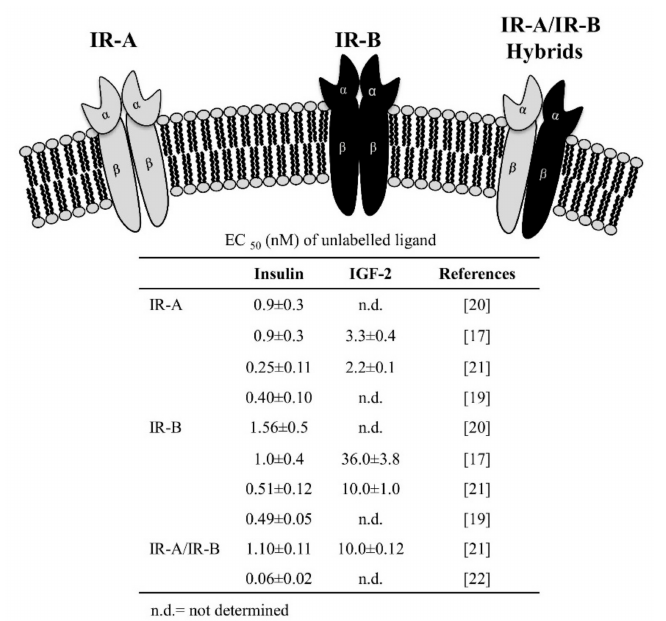
Figure 1. Schematic representation of the insulin receptor (IR) isoforms. Homodimerization of the αβ subunits A or B produces IR-A and IR-B. Heterodimerization of one A and one B αβ subunit forms the hybrid IR. The isoforms are generated by alternative splicing of exon 11 that encoded a 12-amino acid segment in the C-terminus of the α subunit, present in IR-B, but not in IR-A and this difference cause the difference in structure/function. The table indicates the affinity binding (expressed as EC 50 of unlabeled ligand) to insulin and IGF-2 for the IR isoforms and for IR-A/IR-B. When activated by insulin, the IR-B mediates mainly metabolic effects, whereas the IR-A, activated by insulin or IGF-2, mediates mitogenic effects more than IR-B [14]. Both stromal and epithelial cancer cells can locally produce IGF-2 and, since IR-A is a high affinity receptor for IGF-2, the autocrine/paracrine IGF-2/IR-A loop promotes cancer cell proliferation. IR isoforms are expressed as both homodimers (IR-A/IR-A, IR-B/IR-B) and heterodimers (IR-A/IR-B hybrid). In addition, IR isoforms may also form heterodimers with IGF-1R (IR-A/IGF-1R, IR-B/IGF-1R hybrid receptors) [21,22]. The binding affinity of hybrid receptors for the three